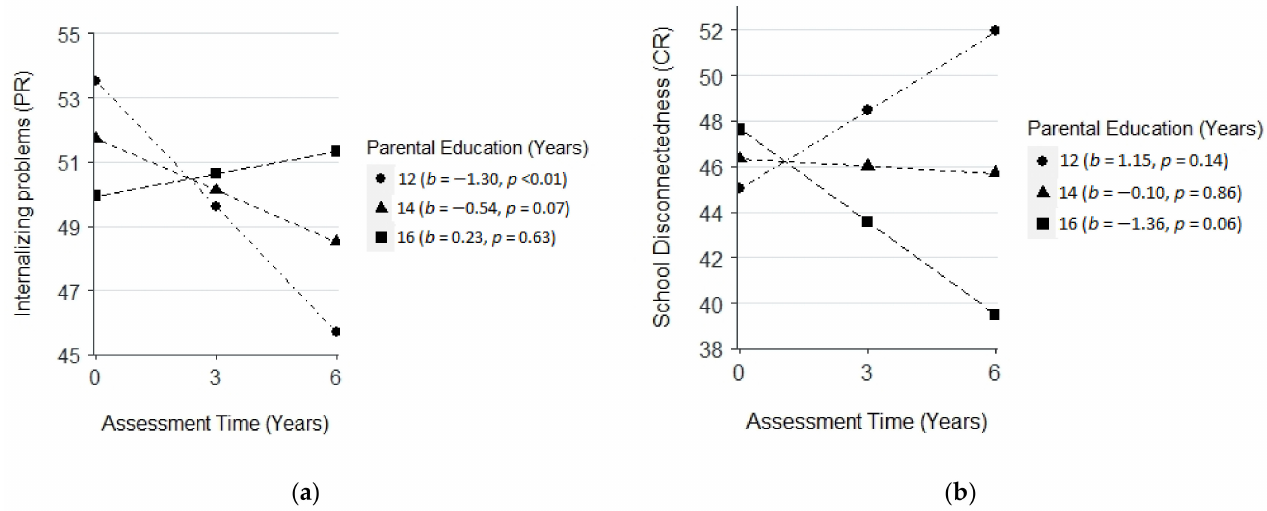
Figure 2. ( a ) plot for the interaction effect between assessment time and parental education on internalizing problems (parent-reported, PR); ( b ) plot for the interaction effect between assessment time and parental education on school disconnectedness (child-reported, CR). Three levels of parental education were plotted: 12 years (1 SD below the mean), 14 years (the mean), and 16 years (1 SD above the